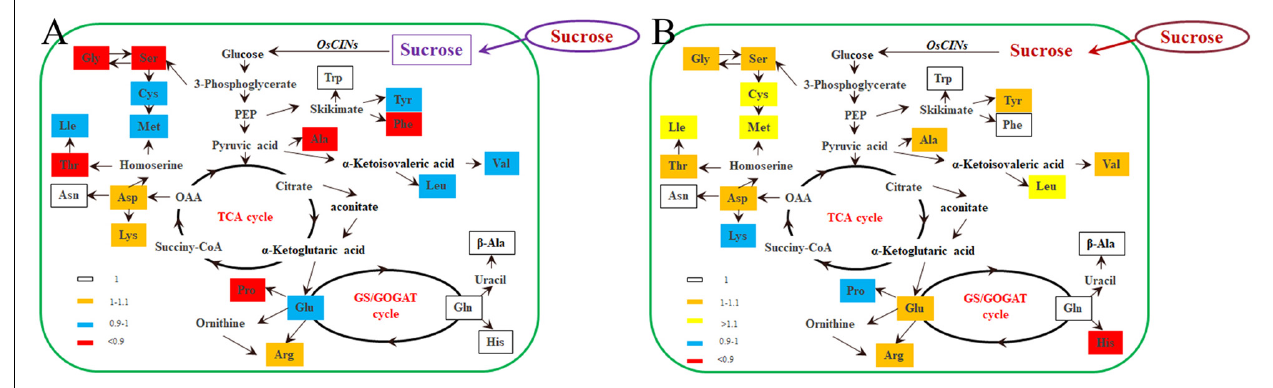
FIGURE 6 | OsDOF11 affects nitrogen metabolism by sugar distribution in flag leaves and seeds. (A) Free amino acid content in flag leaves; (B) free amino acid content in